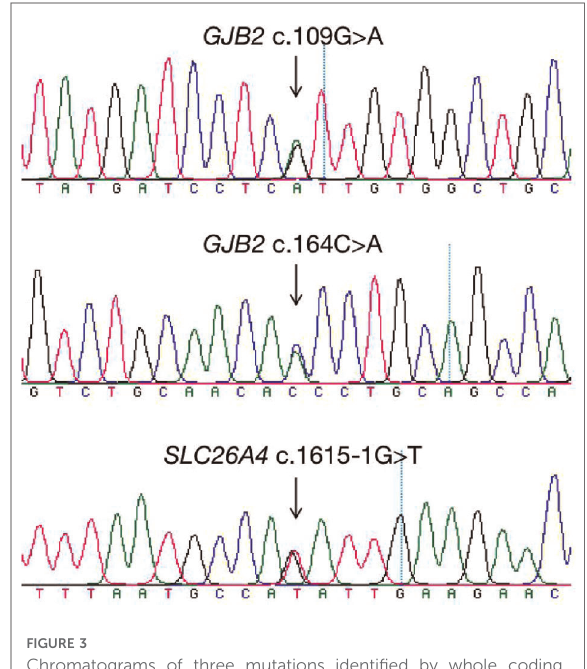
FIGURE 3 Chromatograms of three mutations identi fi ed by whole coding regions